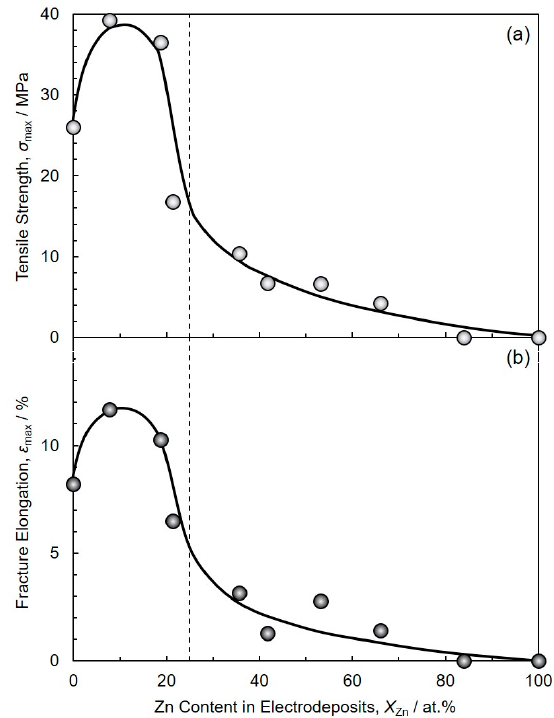
Figure 10. Effect of alloy composition on the tensile strength ( a ) and fracture elongation ( b ) of a pair of Cu rods which are jointed with electrodeposited Sn-Zn alloy films in the cross-section.